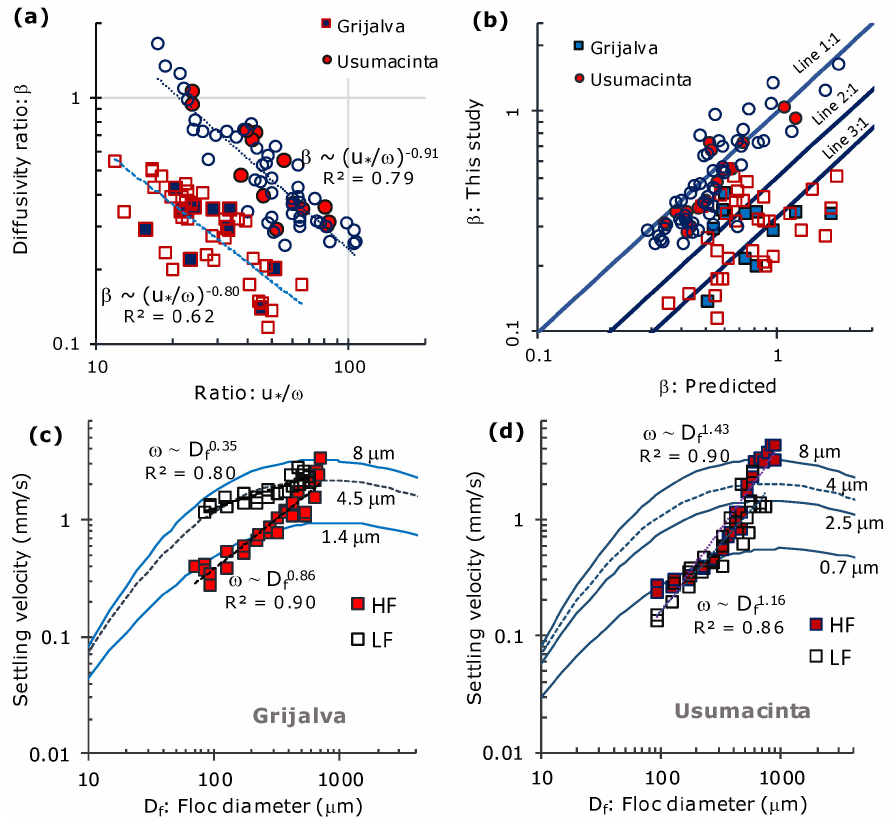
Figure 10. Diffusivity ratio ( β ) and PTV data ( ω f and D f ) at the settling column: ( a ) factor β as a function of u * /w ratio; ( b ) β predicted by de Leeuw et al. 2020 compared to β find in this study; ( c ) and ( d ) bin-averaged settling velocity ( ω ) and floc diameter (D f ) contrasted to KH08. In pan- els ( a ) and ( b ): filled markers: mean monthly β . HF: flocs sampled at the high-flow stage 2016; LF: flocs sampled at the low-flow stage 2017. Blue lines represent models for different primary particle